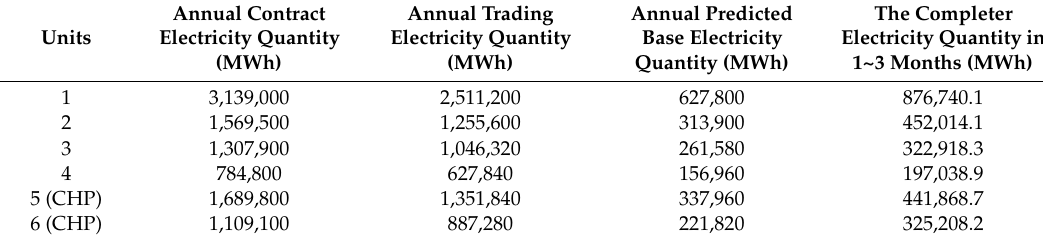
Table 1. Electrical energy data of thermal power units. Table 2. The operation parameters of thermal power units.